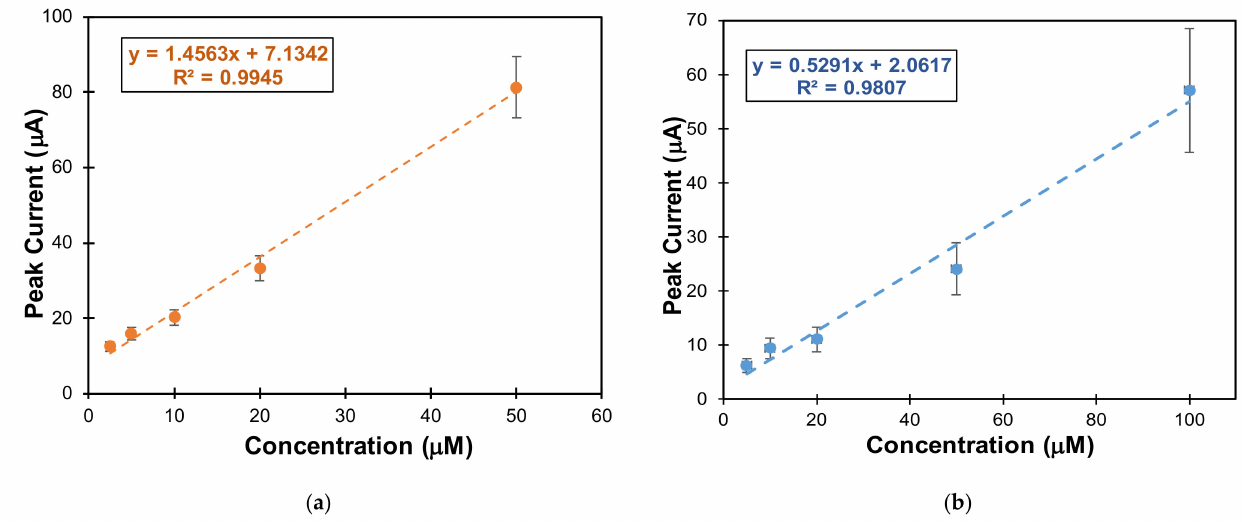
Figure 8. Calibration curves of SFX solutions in phosphate buffer solution, pH = 7.00 at 50 mV · s − 1 using ( a ) MWCNTs-CeO 2 @GCE, and ( b ) MWCNTs-Yb 2 O 3 @GCE sensors. Experimental